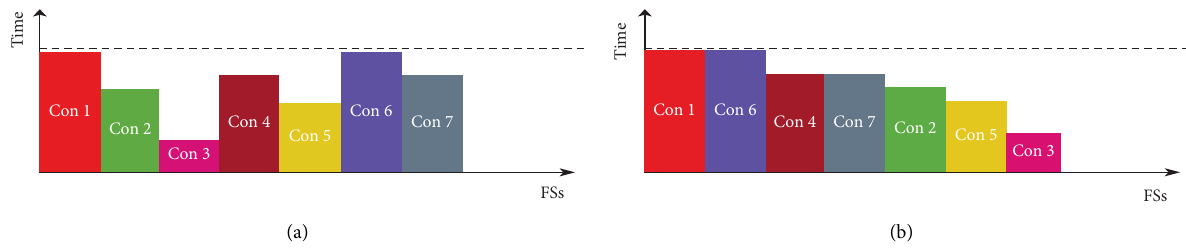
Figure 5: Example scenario spectrum assignment. (a) Normal spectrum allocation without holding time and (b) SA with holding time- based. Table 1: Symbols used in